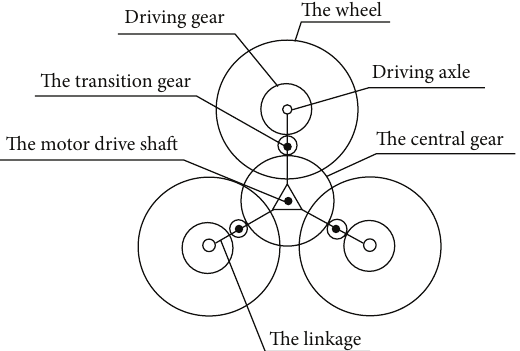
Figure 7: The model of the six-wheel-legged mobile system.